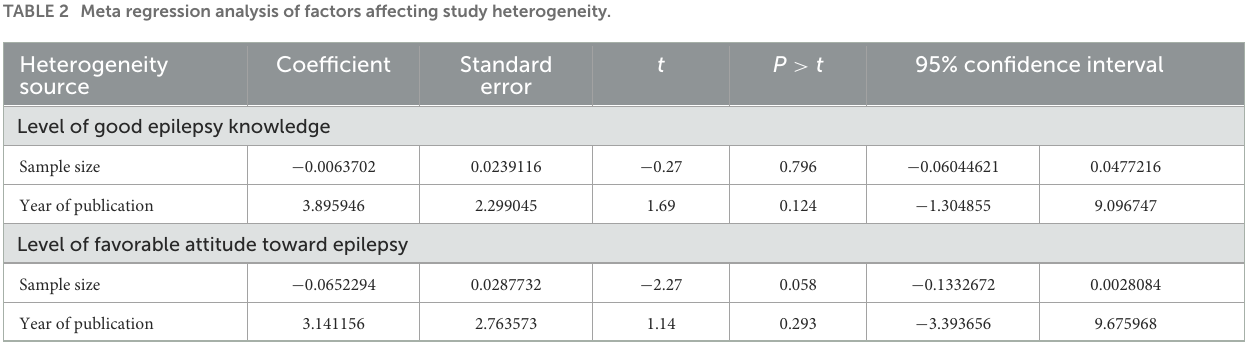
TABLE 2 Meta regression analysis of factors affecting study